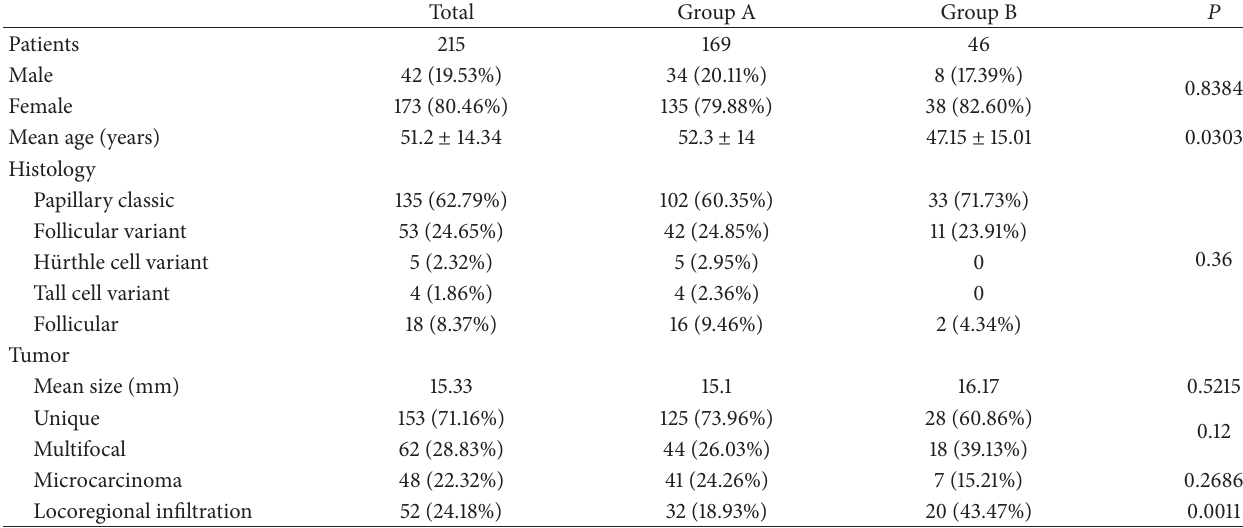
Table 1: Demographic and pathological data of 215 differentiated thyroid cancer patients.